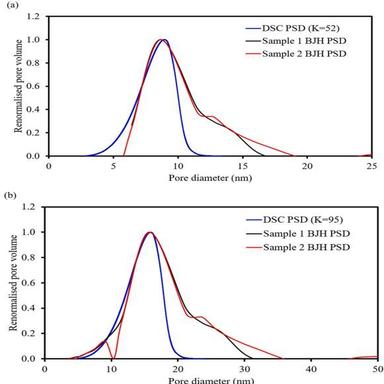
PSD for the region occupied by water adsorbed to a relative pressure of 0.914 obtained by subtracting the nitrogen adsorption BJH PSD (using (a) k = 1 or (b) k = 2 in) obtained after water adsorption from the corresponding PSD from nitrogen adsorption beforehand. Data for experiments on two different samples (1 and 2) from batch G1 are shown to give an idea of intersample variability. Also shown is the PSD for the adsorbed water itself using DSC thermoporometry with a K value of (a) 52 or (b) 9